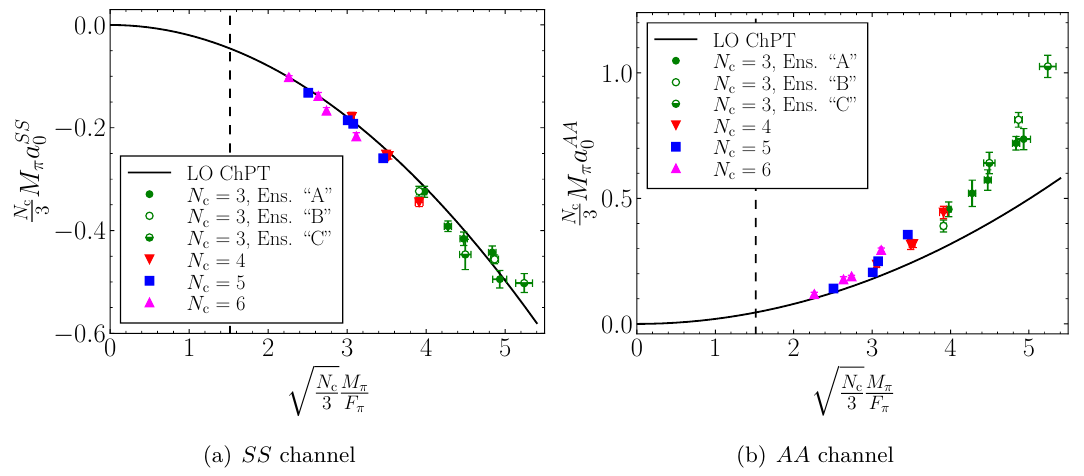
Figure 5 . Results for the s -wave scattering length obtained using the threshold expansion to O ( L − 5 ) , against the LO predictions from ChPT (black solid line). Both axis have been multiplied by a N -dependent factor to eliminate leading N c a vertical dashed